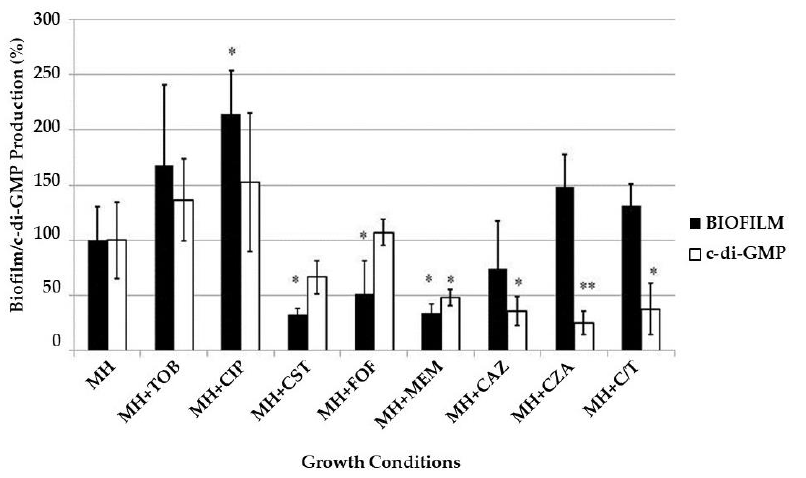
Figure 7. P. aeruginosa PAO1 biofilm and c-di-GMP production after exposure to sub-MIC of eight different antibiotic/antibiotic combinations. P. aeruginosa biofilms were developed for 24 h at 37 °C in Mueller-Hinton (MH) broth alone or supplemented with1/4× MIC of tobramycin (TOB), ciprofloxacin (CIP), colistin (CST), fosfomycin (FOF), meropenem (MEM), ceftazidime (CAZ), ceftazidime/avibactam (CZA) or ceftolozane/tazobactam (C/T). Biofilm and c-di-GMP production were measured by crystal violet staining and by GFP fluorescence measurement, respectively. The obtained values were normalized by biofilms OD 625 and are expressed as percent of the value ob- tained with the biofilms developed without antibiotic; the results are reported as average of three biological replicates ± standard deviation. *, p < 0.05; **, p < 0.001.